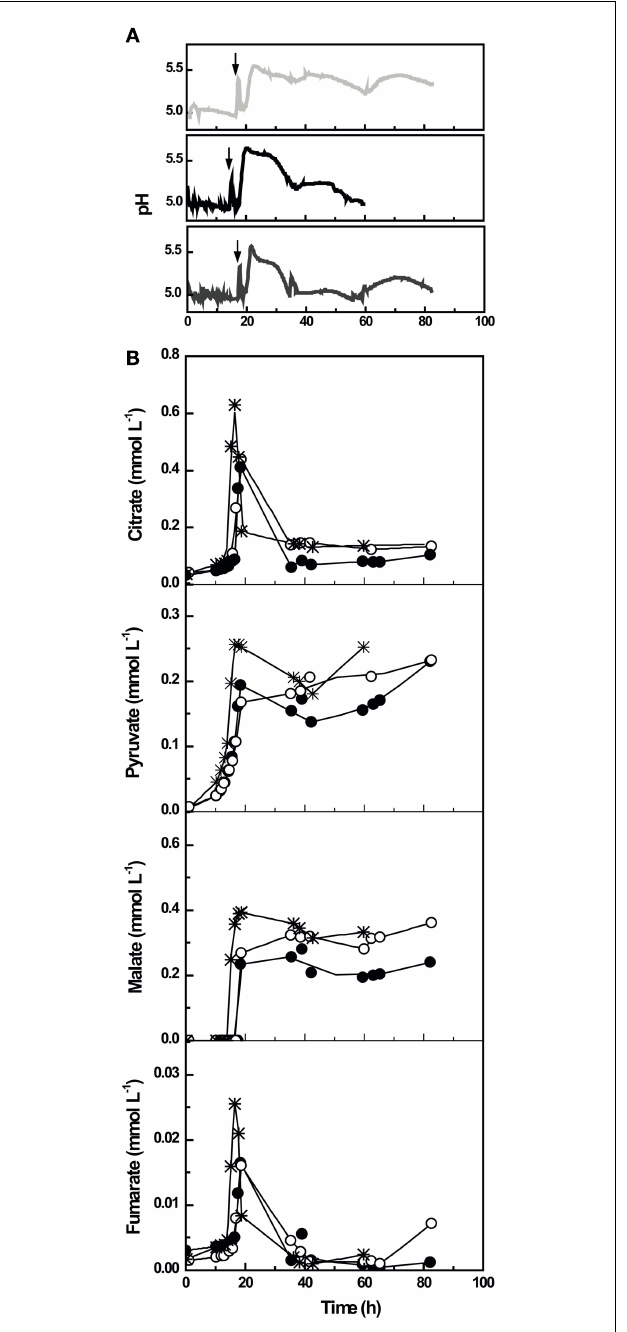
FIGURE 6 | Organic acid excretion and reuptake of organic acids in NH 4 -limited bioreactor batch cultures of Penicillium ochrochloron CBS 123824 at pH 5 illustrated with three independent cultivations. (A) Progress of extracellular pH of three independent cultivations in the following order: Batch #1 (gray line), batch #2 (black line), batch #3 (dark gray line).The exhaustion of ammonium is marked with an arrow. Note that culture pH was controlled only by sodium hydroxide. (B) Progress of organic acid excretion of three independent cultivations exemplified with citrate, pyruvate, malate, and fumarate. Batch #1 ( (cid:2) ), batch #2 ( • #3 ( ). Average of three independent experiments from one specific time point of cultivation is depicted in Figure 3 (at 35.0 ± 0.65h of